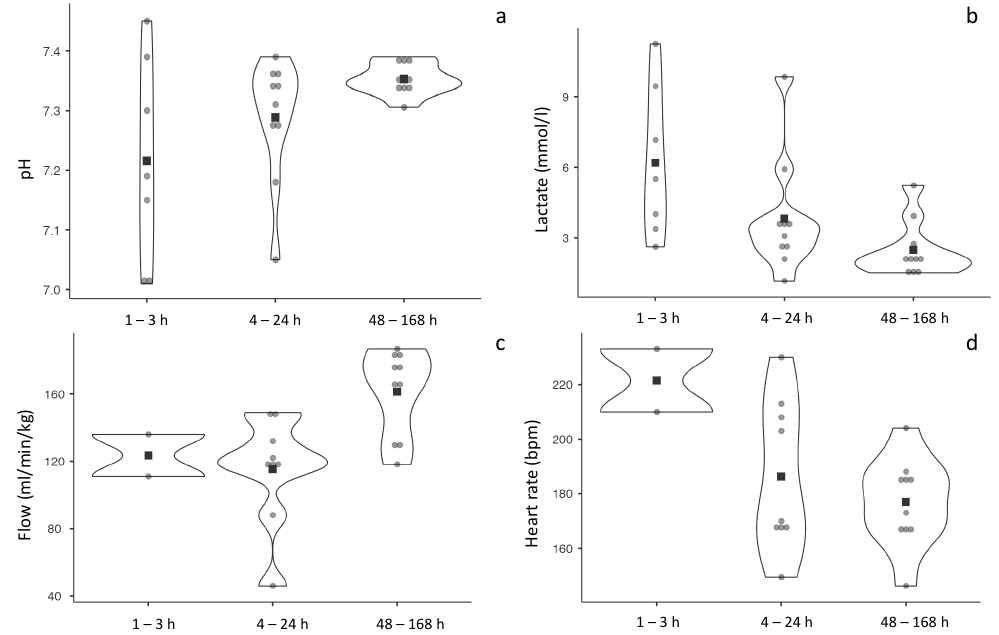
Figure 3. Distribution of pH, lactate, circuit flow and heart rate during the whole experiment in the experimental groups. Violin plots showing ( a ) pH, ( b ) lactate (mmol/L), ( c ) circuit flow normalized by fetal weight (mL/kg/min), and ( d ) fetal heart rate (BPM). Each point (•) represents mean value of each animal considering whole experiment and black square ( ) mean value of each experimental group.